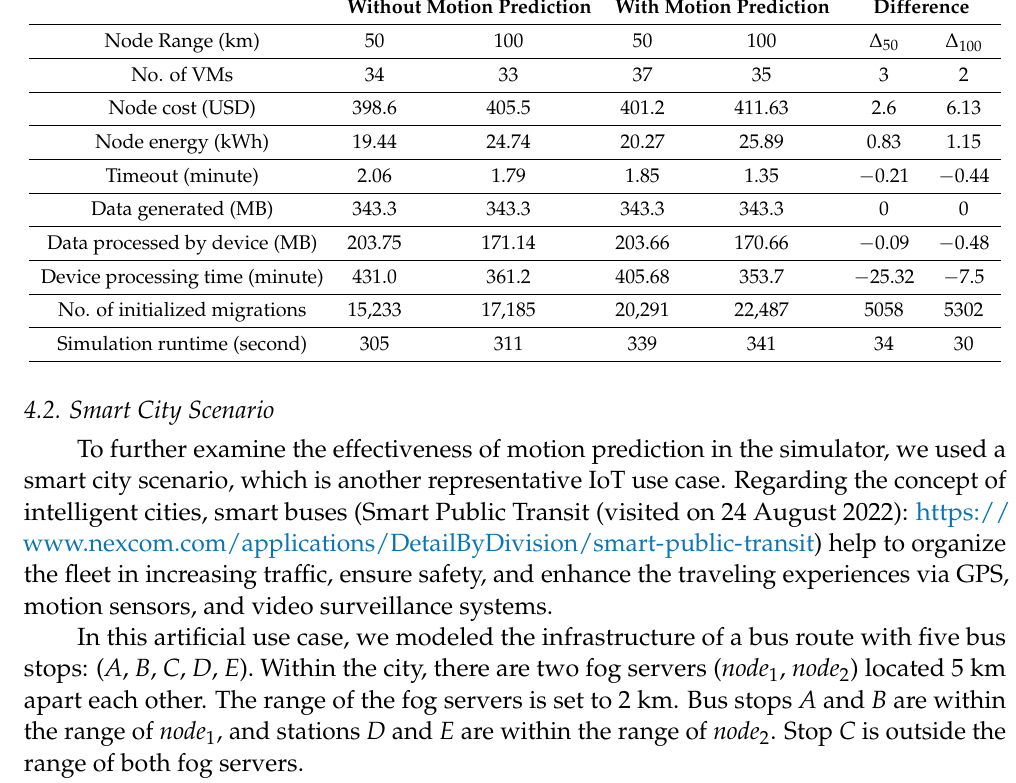
Table 2. Results of the scenario, simulating drone movements Without Motion Prediction With Motion Prediction Difference Node Range